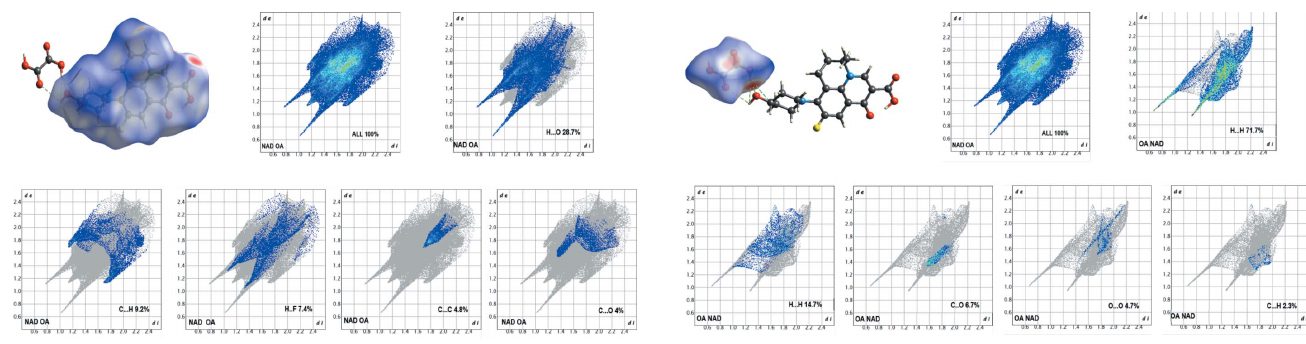
Figure 7 Two-dimensional fingerprint plots and relative contribution of various interactions to the Hirshfeld surface of the OA